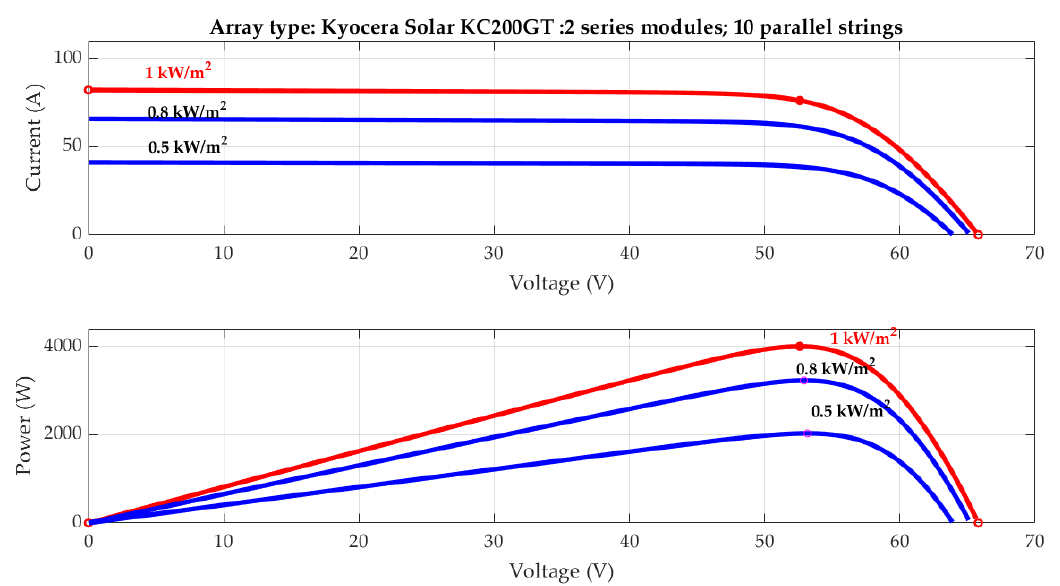
Figure 21. V-I and P-V characteristics of the PV system under PSC.